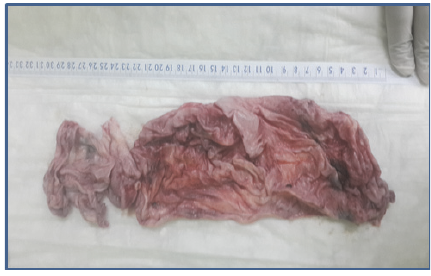
Figure 3: Total excision of the cyst measured around 31